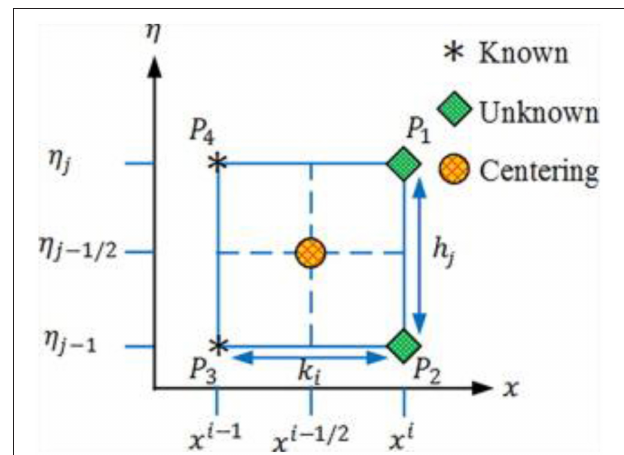
FIGURE 2 | Schematic representation of